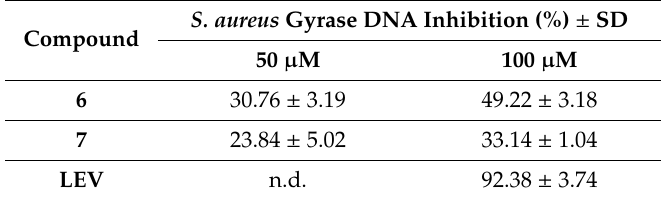
Table 4. Inhibitory activity of 6 and 7 against S. aureus DNA